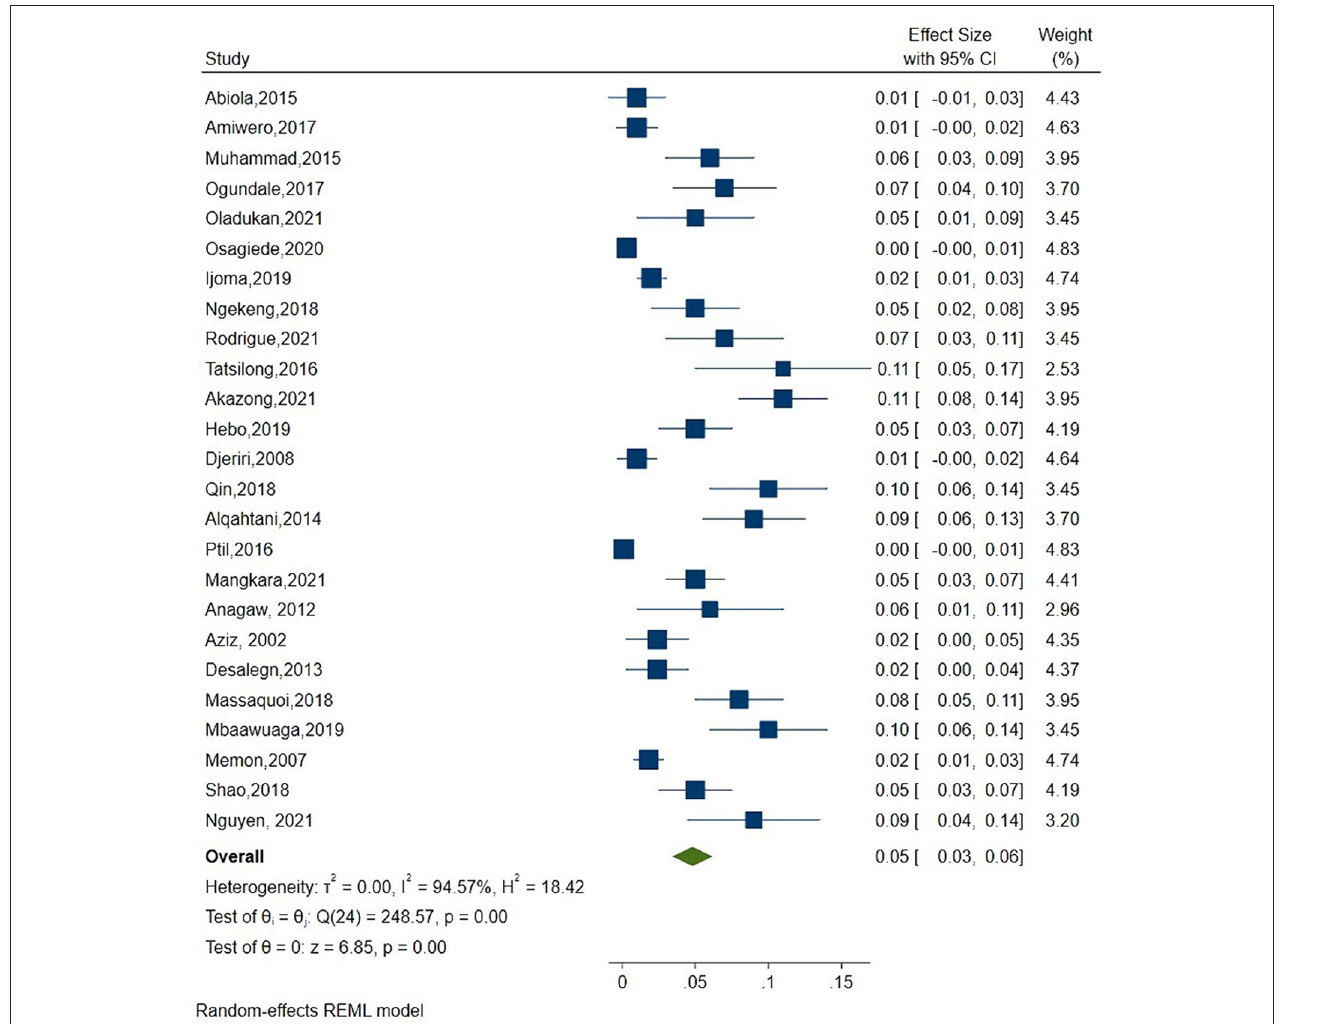
FIGURE 2 | Forest plot of overall seroprevalence estimate of the Hepatitis B infection among healthcare workers.